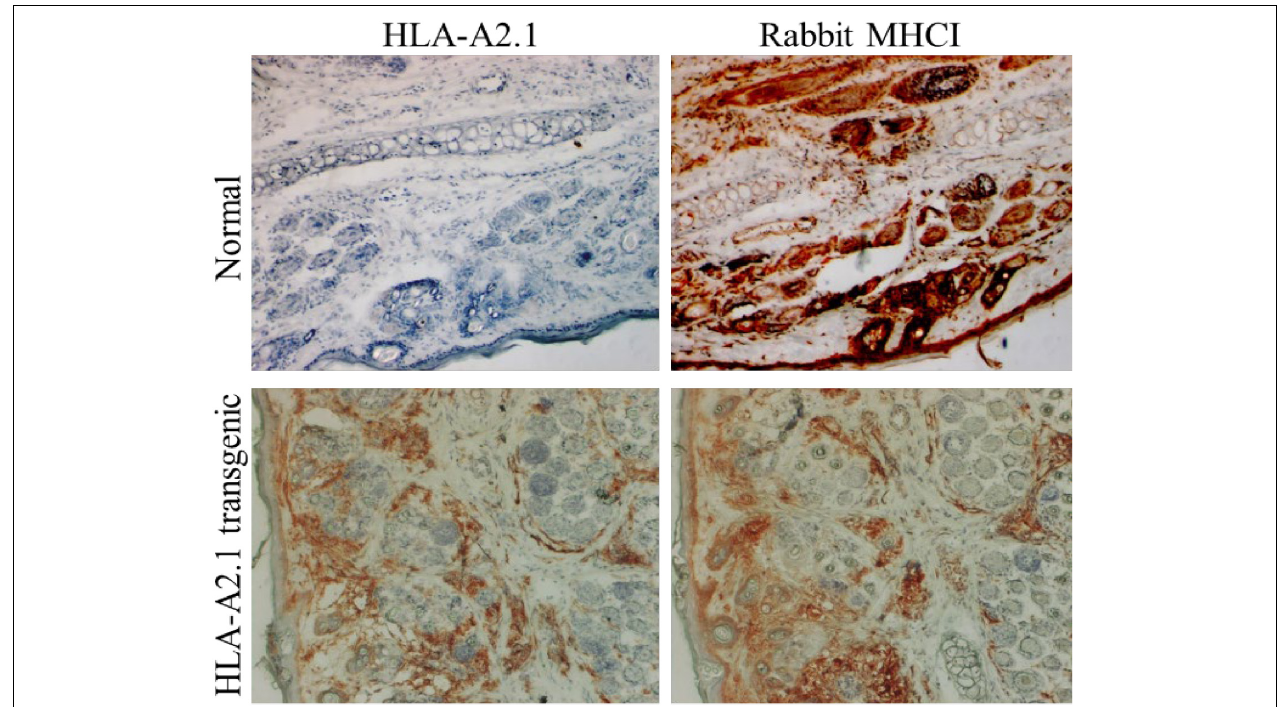
FIGURE 3 | An HLA-A2.1 transgenic rabbit model. Ear biopsies from a normal rabbit and an HLA-A2.1 transgenic rabbit were stained for antibodies against either HLA-A2.1 (BB7.2 clone) or rabbit MHCI. The HLA-A2.1 transgenic rabbit (lower panels) expressed both HLA-A2.1 and rabbit MHCI on the cell surface while the wild-type rabbit (upper panels) showed no HLA-A2.1 expression but strong MHCI (20 × ). These rabbits have been used for studying HPV associated pathogenesis and T cell-based vaccine development against